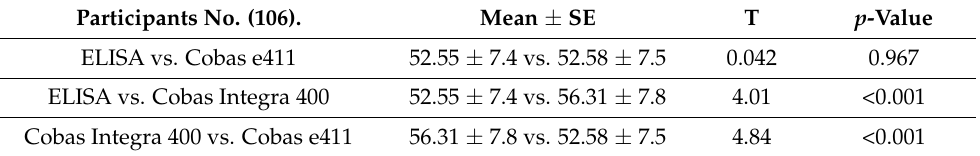
Table 3. Comparison of the mean serum ferritin concentrations between the methods. Participants No. (106).